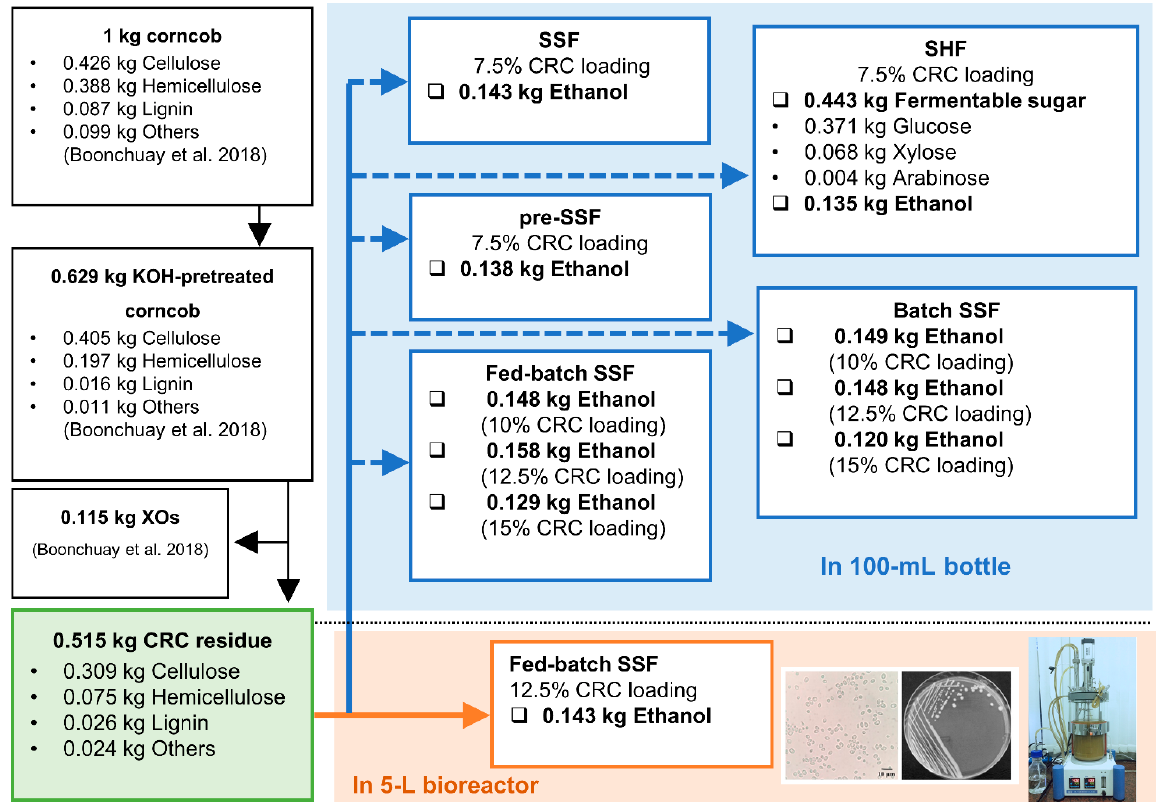
Figure 5. Mass balance of bioethanol production from cellulose-rich corncob residue by the thermotolerant S. cerevisiae TC-5.